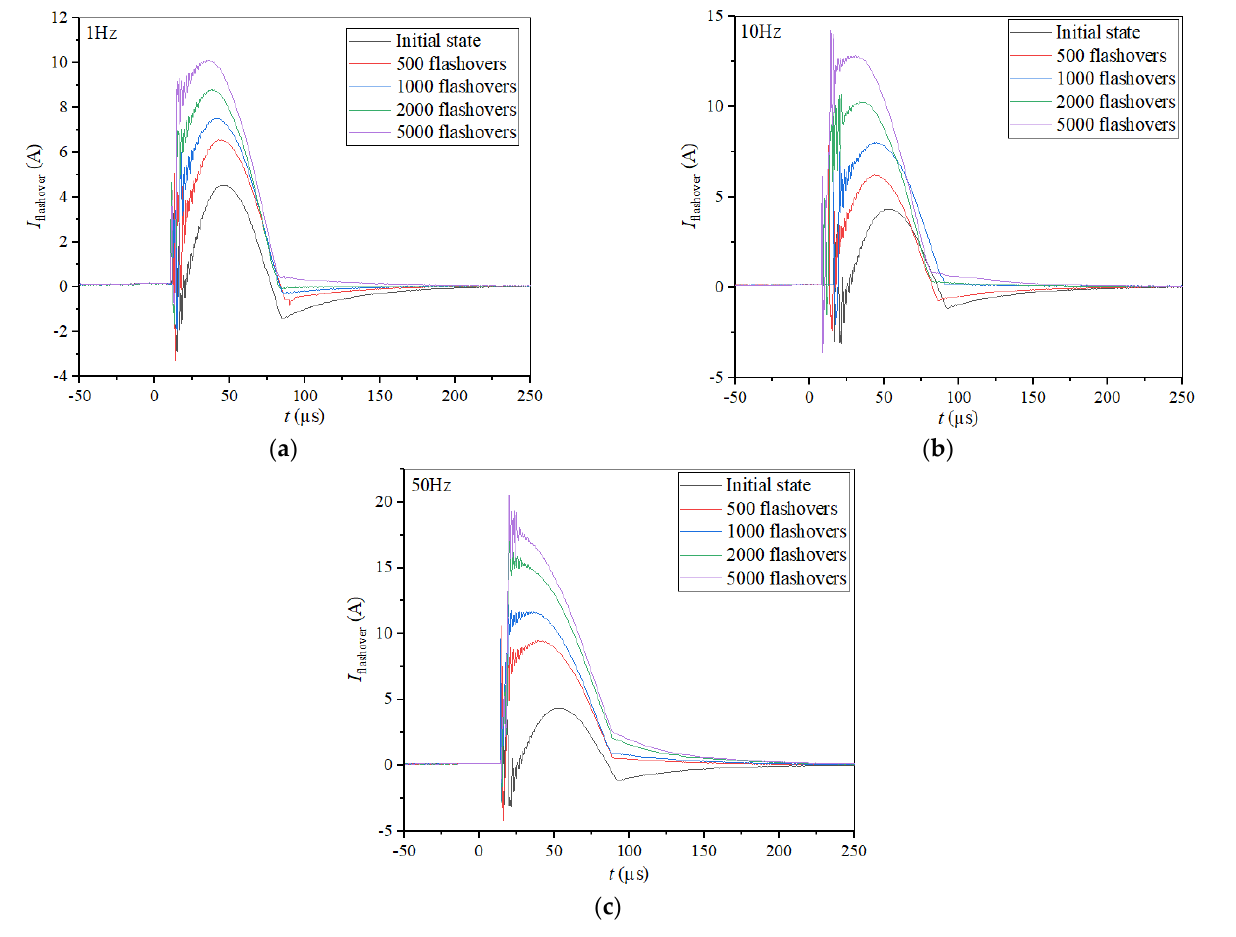
Figure 12. Flashover current during the aging process at ( a ) 1, ( b ) 10 and ( c ) 50Hz.